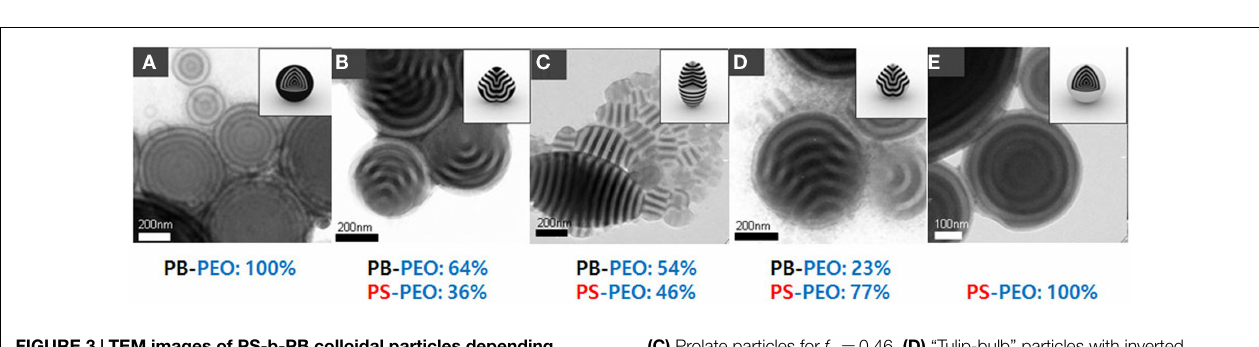
FIGURE 3 | TEM images of PS-b-PB colloidal particles depending on the volume ratio ( f s ) of PS block in the mixed surfactant of PS-b-PEO and PB-b-PEO: (A) particles with onion-like morphology for f s = 0 . (B) “Tulip-bulb” particles for f s = 0.36.